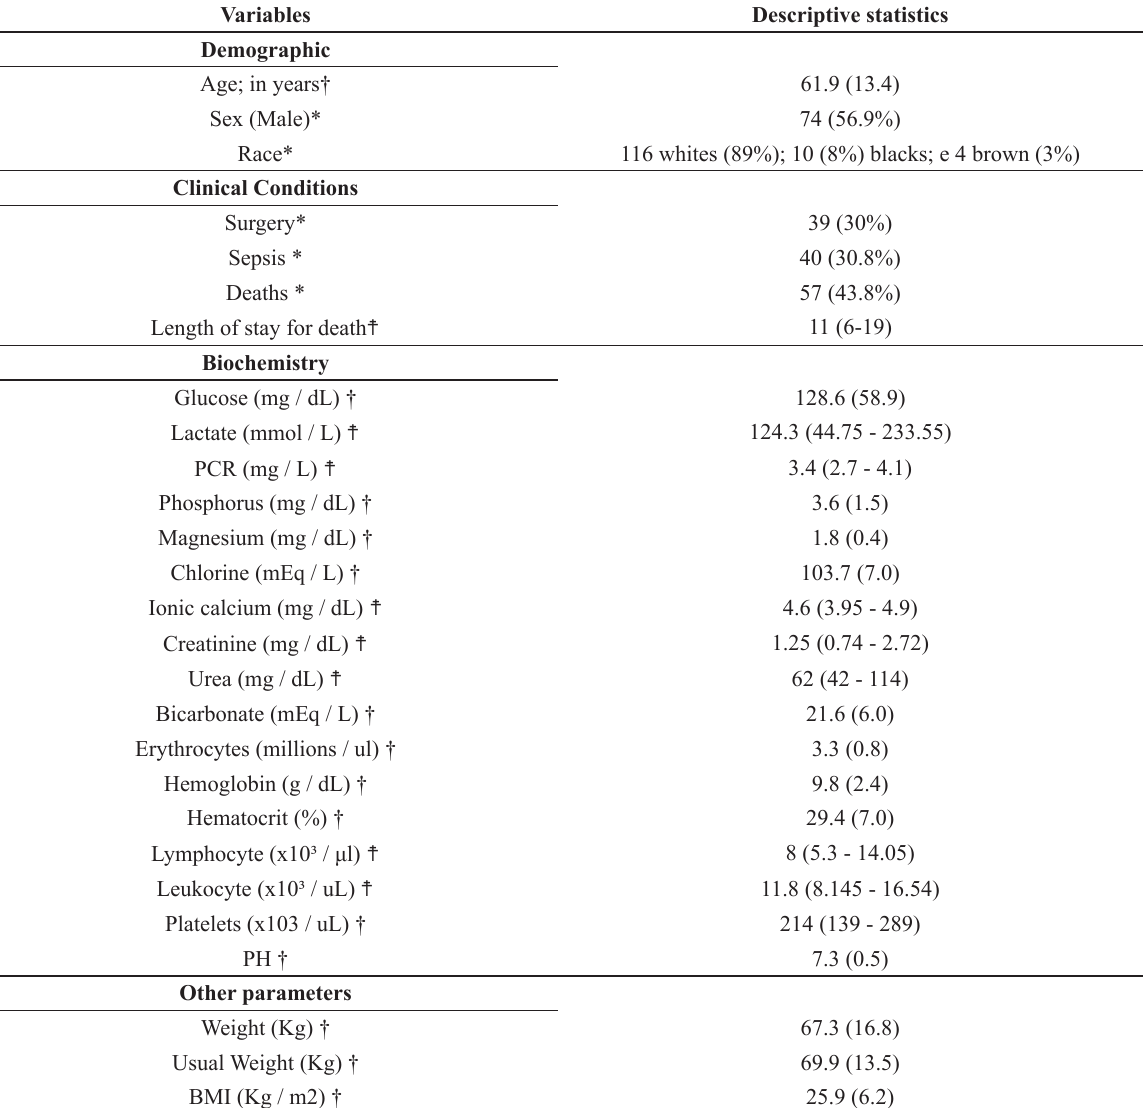
Characteristics of the